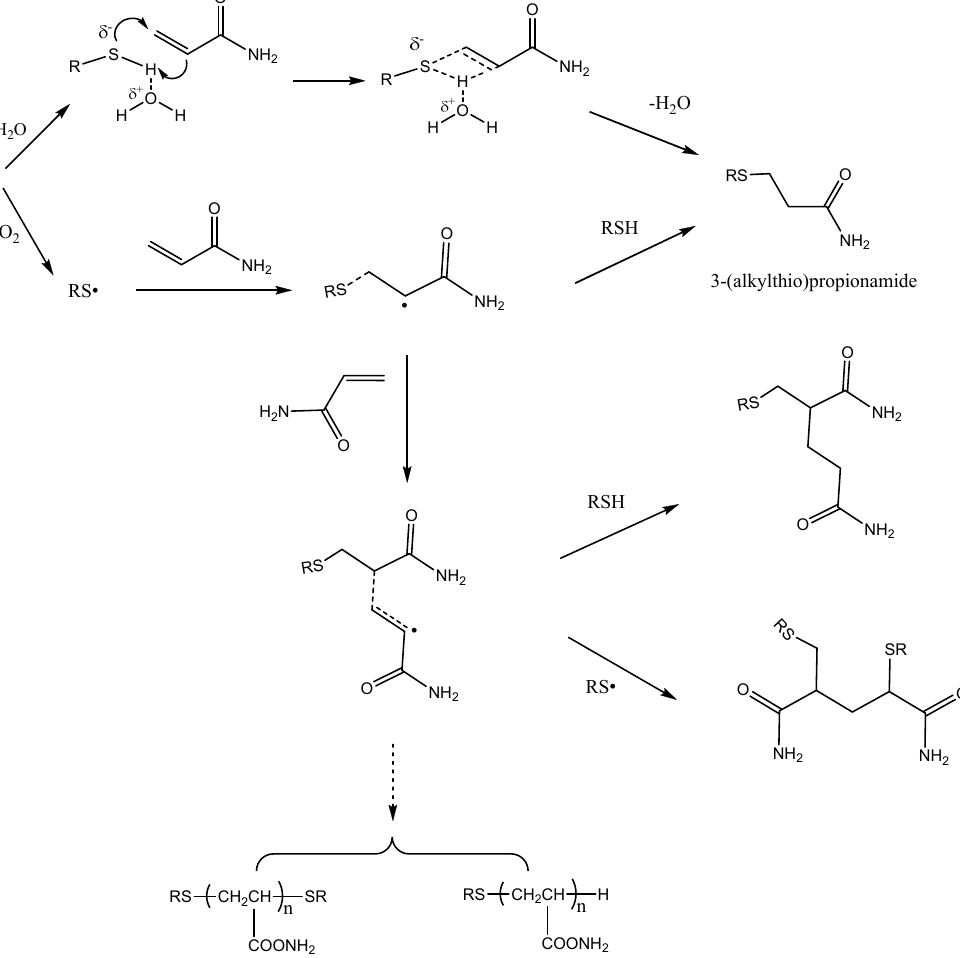
Figure 6. Proposed pathways for the disappearance of acrylamide in the presence of mercaptans.